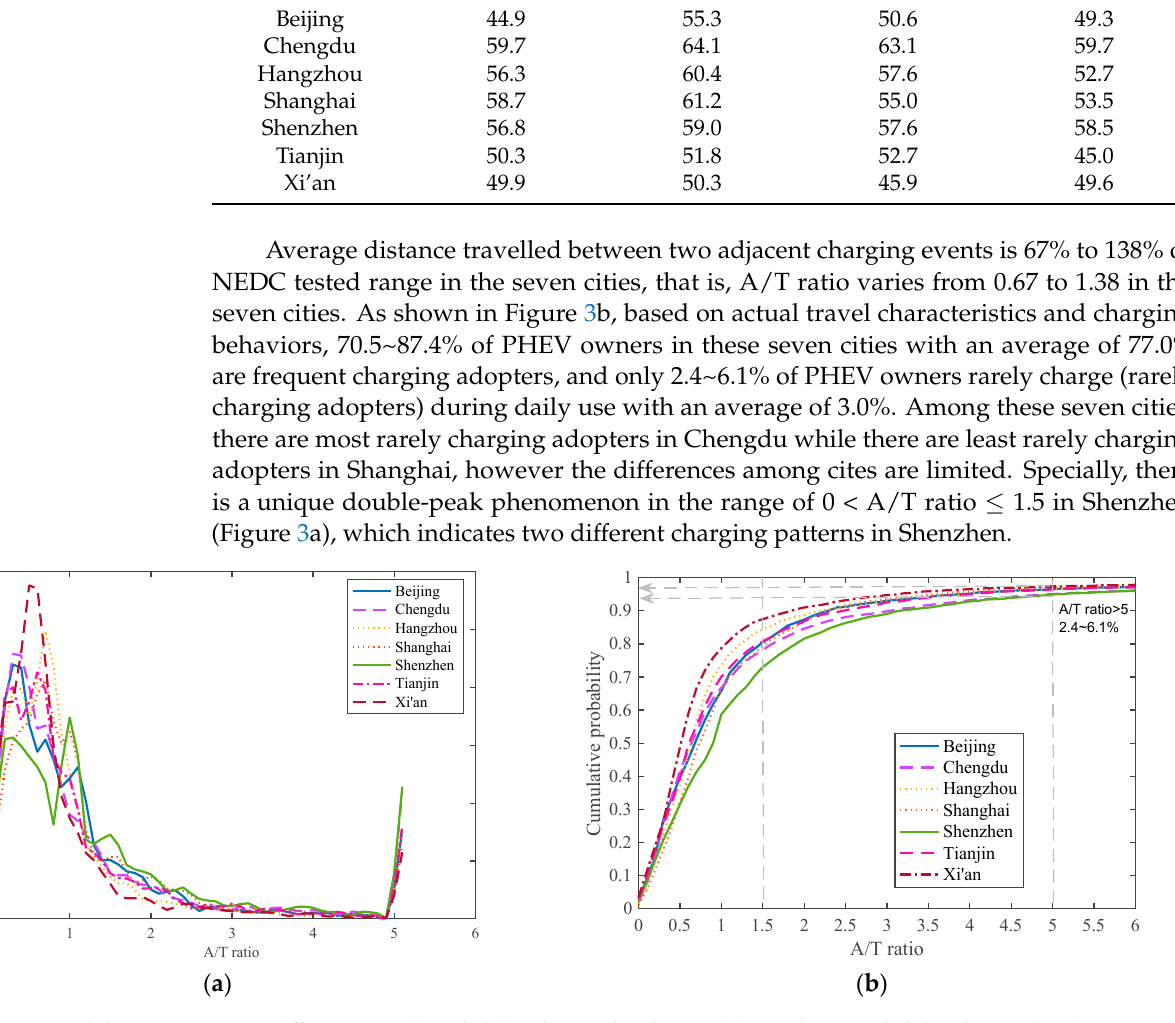
Figure 3. Actual charging pattern in different cities ( a ) probability density distribution ( b ) cumulative probability density distribution. Standard UF of PHEV50 (50-km-all-electric range PHEV) varies from 0.55 to 0.62,